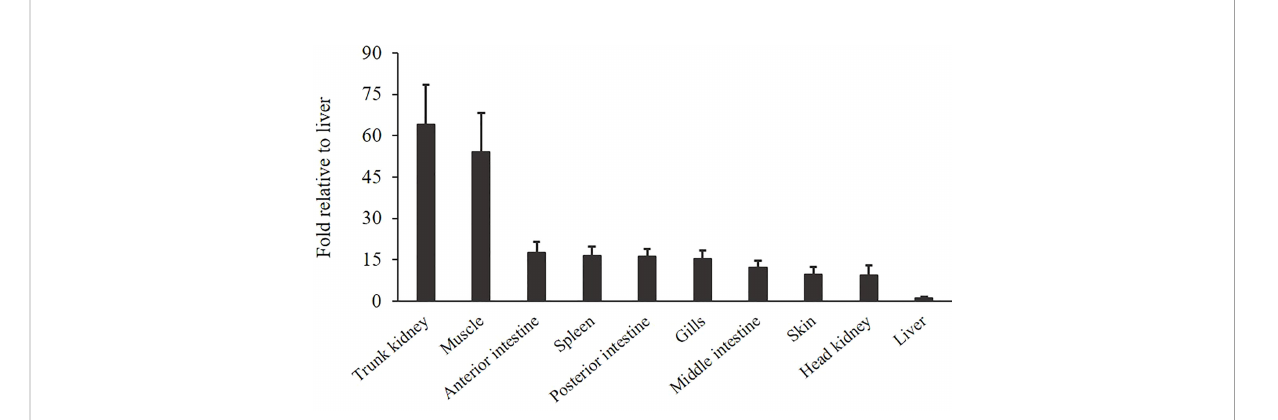
FIGURE 5 Gene expression of OnSARM1 in tissues from healthy tilapia. The expressions of OnSARM1 in the trunk kidney, muscle, anterior intestine, spleen, posterior intestine, gills, middle intestine, skin, head kidney, and liver were analyzed using real-time PCR and normalized to the expression of EF-1 a . Data are expressed as mean + SD (n = 4) and presented as fold change relative to the